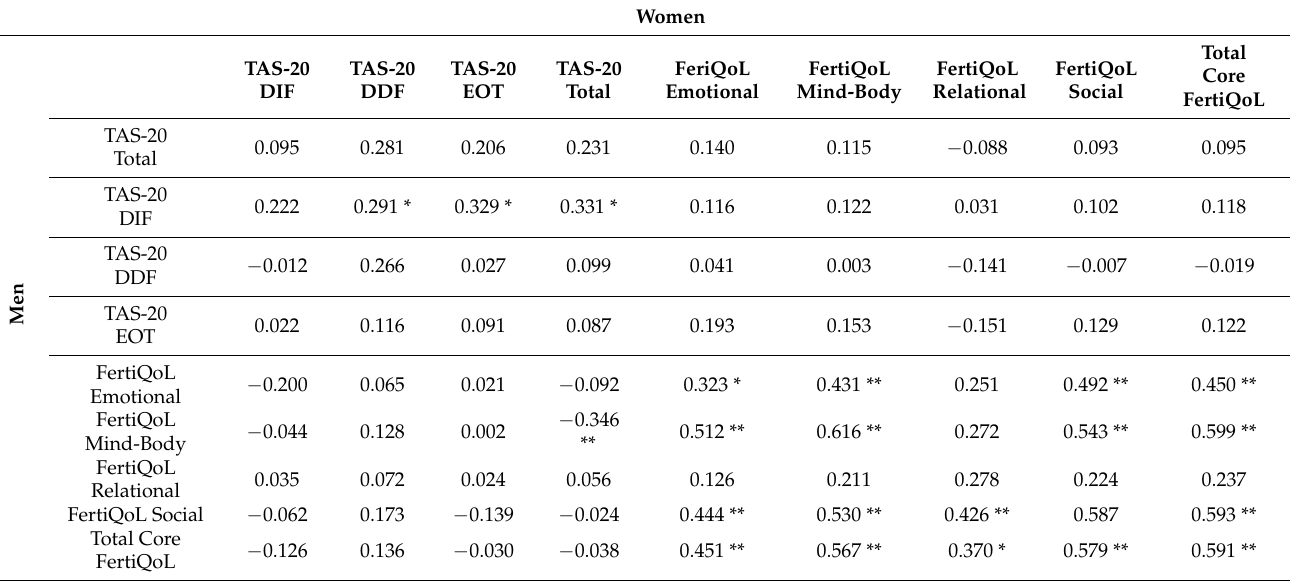
Table 2. Association between alexithymia and quality of life in women and men.